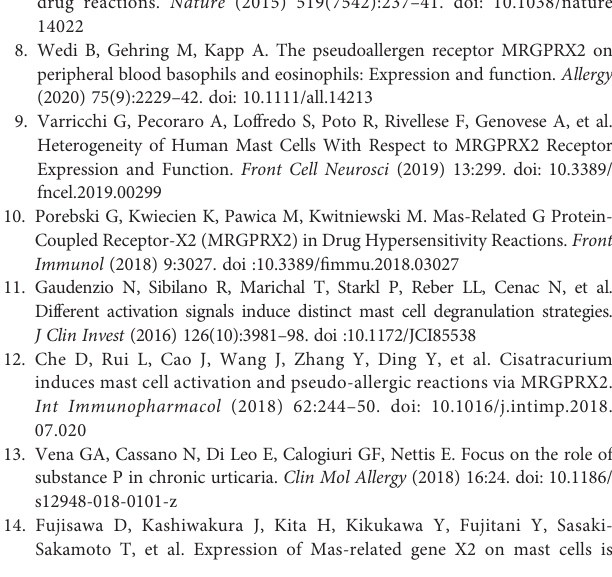
Supplementary Figure 1 | Representative example of fl owcytometry results for CD63 upregulation upon C48/80 induced degranulation of HMC. Degranulated mast cells are in Q2: they are CD63 positive, and have increase sideward scatter. (A) . For the negative control condition, only 0.290% of all cells are degranulated. (B) . After stimulation with C48/80, 25.7% of HMC1 are in Q2, thus considered degranulated. Supplementary Figure 2 | Con fi rmation of MRGPRX2 RNA expression by HMC1. A clear mRNA expression of MRGPRX2 was shown to be present in HMC1 (n=3), but not in PBC (n=2), which were used as negative control. Mean with SEM is shown for CT values. Supplementary Figure 3 | QWF dose-dependently inhibits C48/80 induced HMC1 degranulation. A titration of QWF doses was performed to identify the optimally inhibiting dose of QWF. Two representative experiments are shown. HMC1s, pre-incubated with Lat-B, were fi rst incubated with QWF for 10 minutes and subsequently stimulated with C48/80 for 60 minutes. A dose-dependent decrease of QWF on CD63 expression was found. Supplementary Figure 4 | Control conditions of the compounds used in this study. The effect of DMSO and QWF alone on the activation of HMC1 was investigated as an extra control. The highest concentrations used in the study were taken: 0.28% DMSO, and 100 µg/ml QWF. (A) Both DMSO and QWF did not induce relevant b -hexosaminidase release (n=3). (B) QWF appeared to induce a nonspeci fi c CD63 upregulation although not statistically signi fi cant compared with the diluent control DMSO